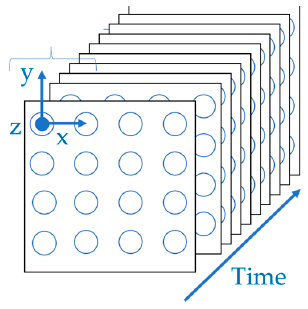
Figure 8. Image of sensor data.